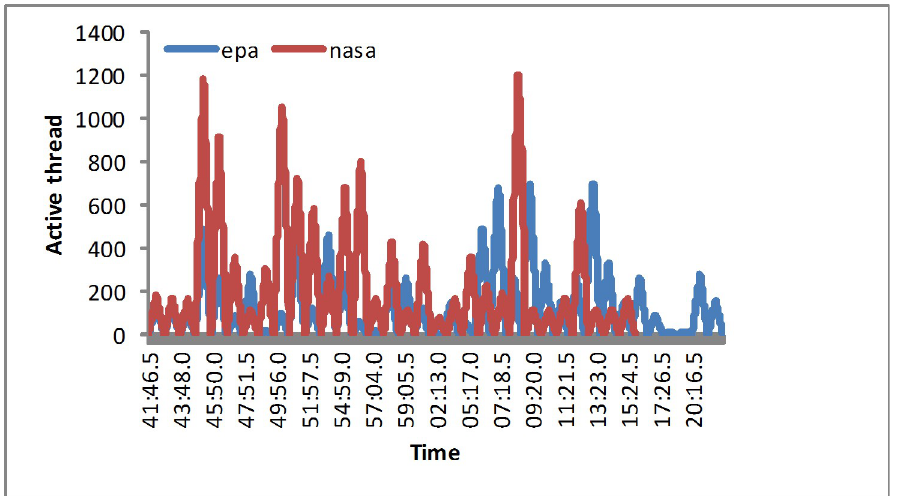
Fig 4. Real EPA and NASA tests in the second